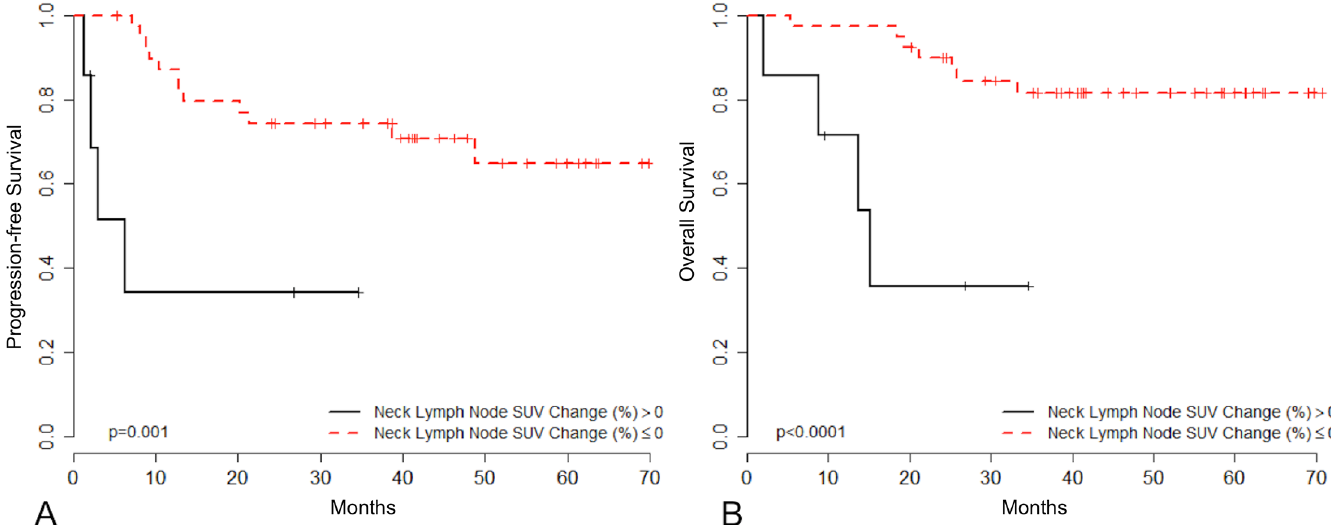
Fig 3. Clinical outcome according to neck lymph node SUV change after cycle 1 of IC. Progression-free survival (3A) and overall survival (3B) of patients who underwent D14-C1-IC 18 F-FDG PET/CT according to the change in the maximum SUV of regional lymph nodes after the first cycle of IC (N = 47). Patients with tumors demonstrating no change or decrease in neck lymph node SUV (neck lymph node SUV change (%) (cid:20) 0) were considered responders (N = 40; red) and those with tumors showing an increase in neck uptake (Neck Lymph Node SUV Change (%) > 0) were considered non-responders (N = 7; black).